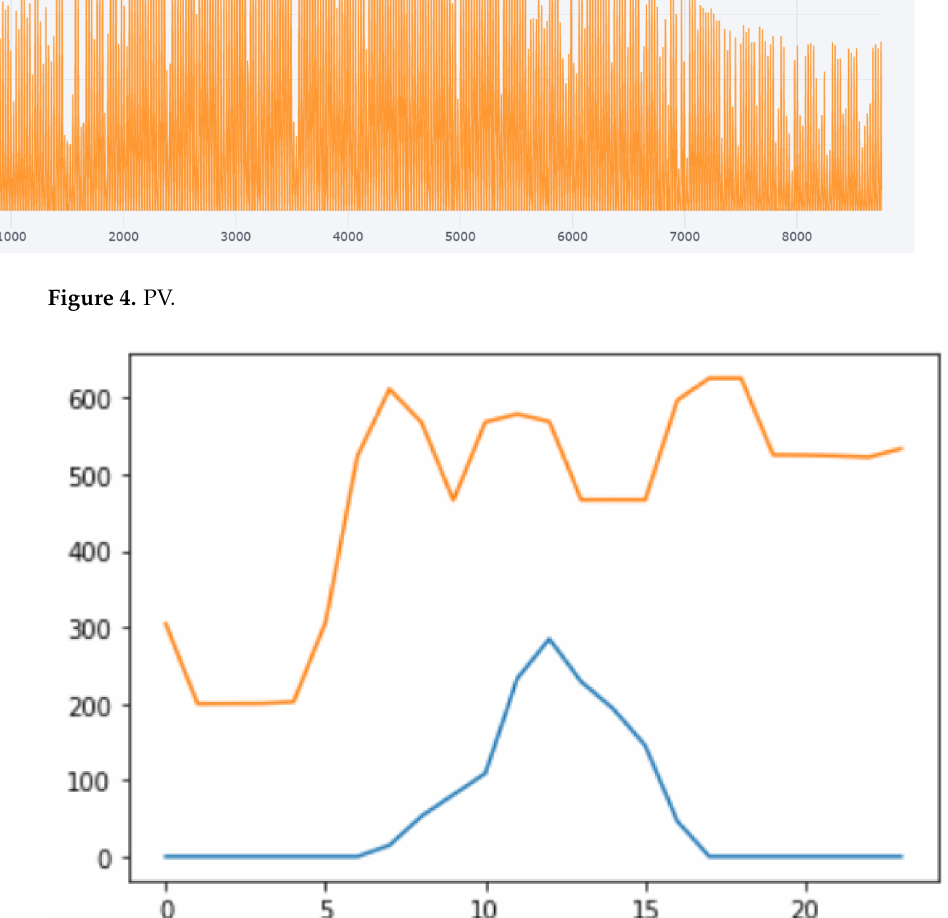
Figure 5. PV and load for the next 24